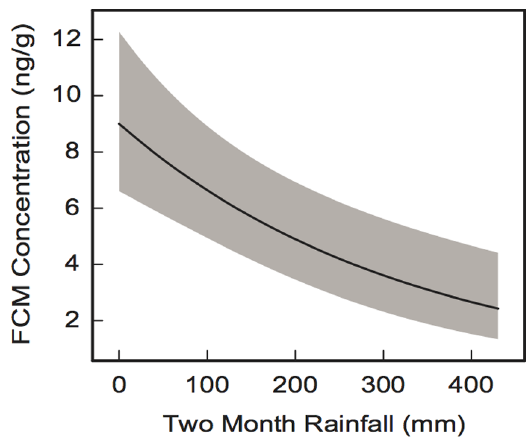
Figure 3. Faecal cortisol metabolite (FCM) concentration versus rainfall during the two months before the collection. The grey band shows the 95% prediction interval. The total rainfall for the previous 4 months (months 3 to 6) is assumed to equal its average